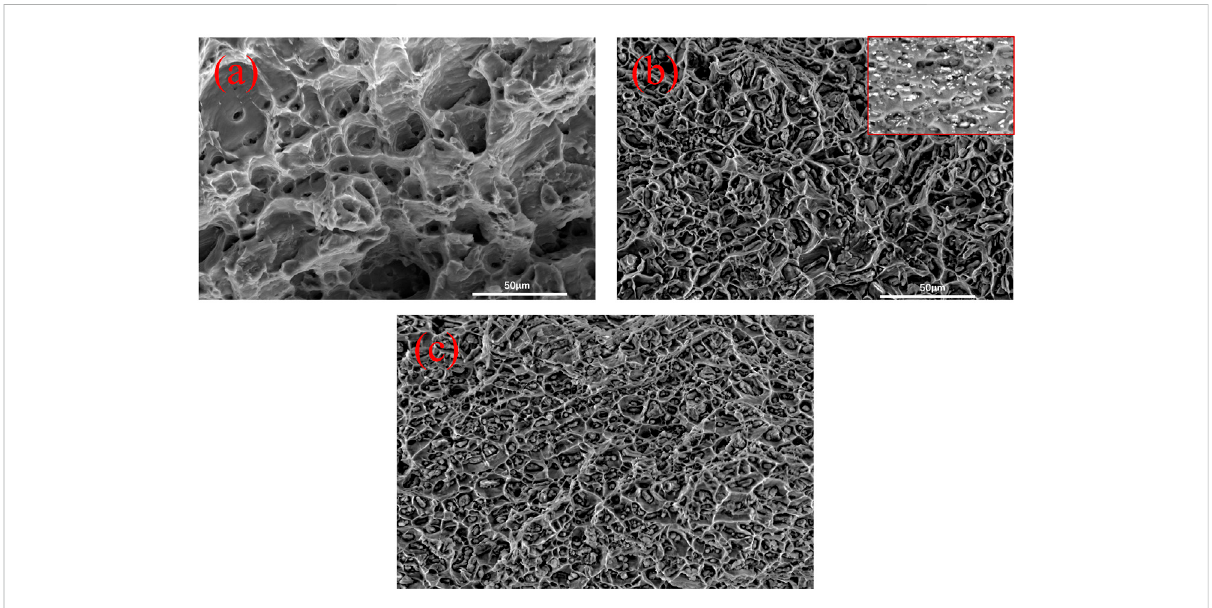
FIGURE 6 SEM tensile fracture surfaces of (A) as cast L14, (B) as-cast LT146, and (C) LT146-LSR. The inserted of (B) is the corresponding backscatter SEM image.